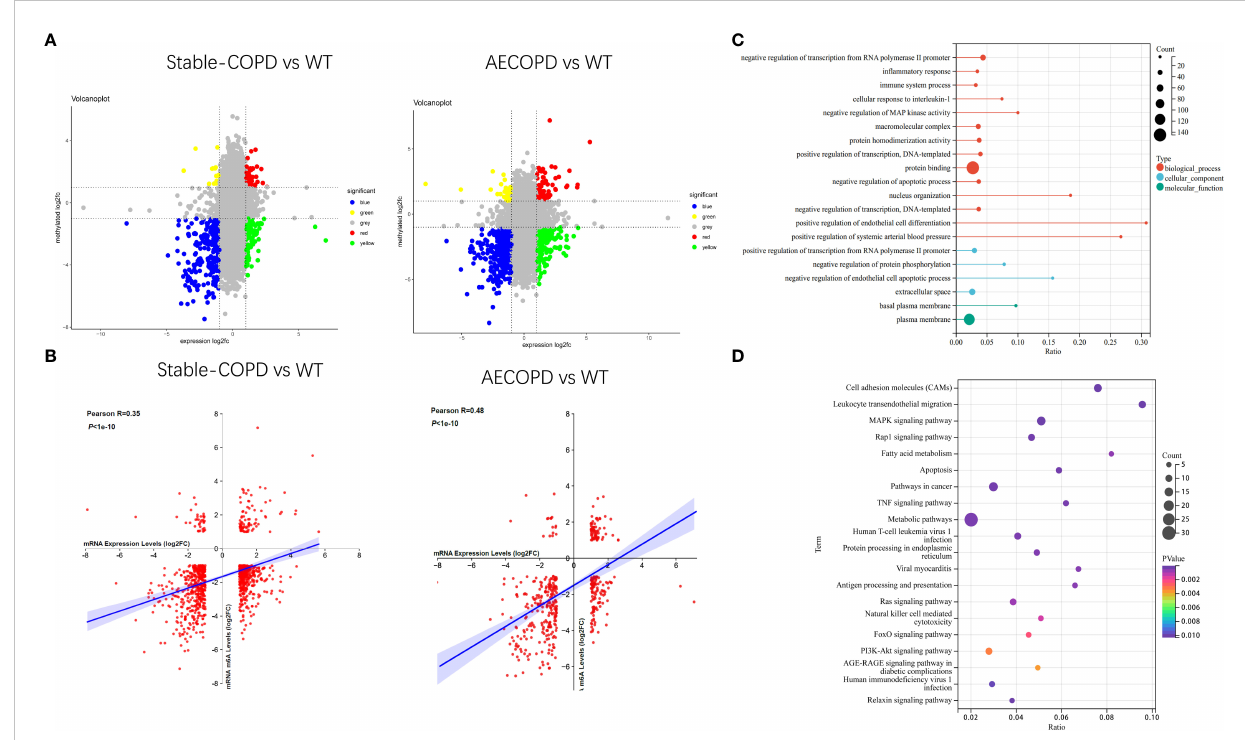
FIGURE 8 Joint analysis of MeRIP-seq and RNA-seq data: (A) Four quadrant graph shows the differentially methylated peaks in differentially expressed mRNAs (| log2FC>1, P < 0.05). (B) There was a positive correlation between differentially methylated mRNAs and the mRNA expression level (0.3<Pearson R <0.5, P < 1e-10). (C, D) GO and KEGG enrichment analyses of mRNAs with differential methylation and